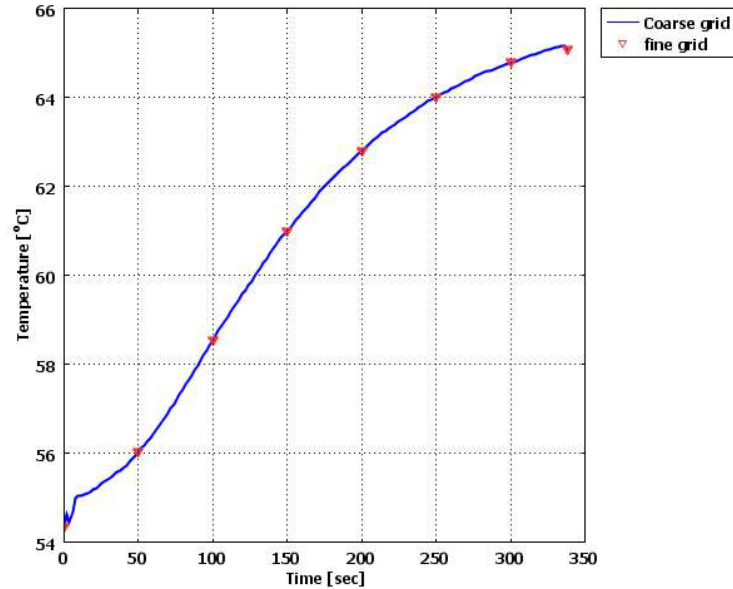
Figure 12. Calculated temperature at the steel/lining interface obtained for coarse and fine mesh.